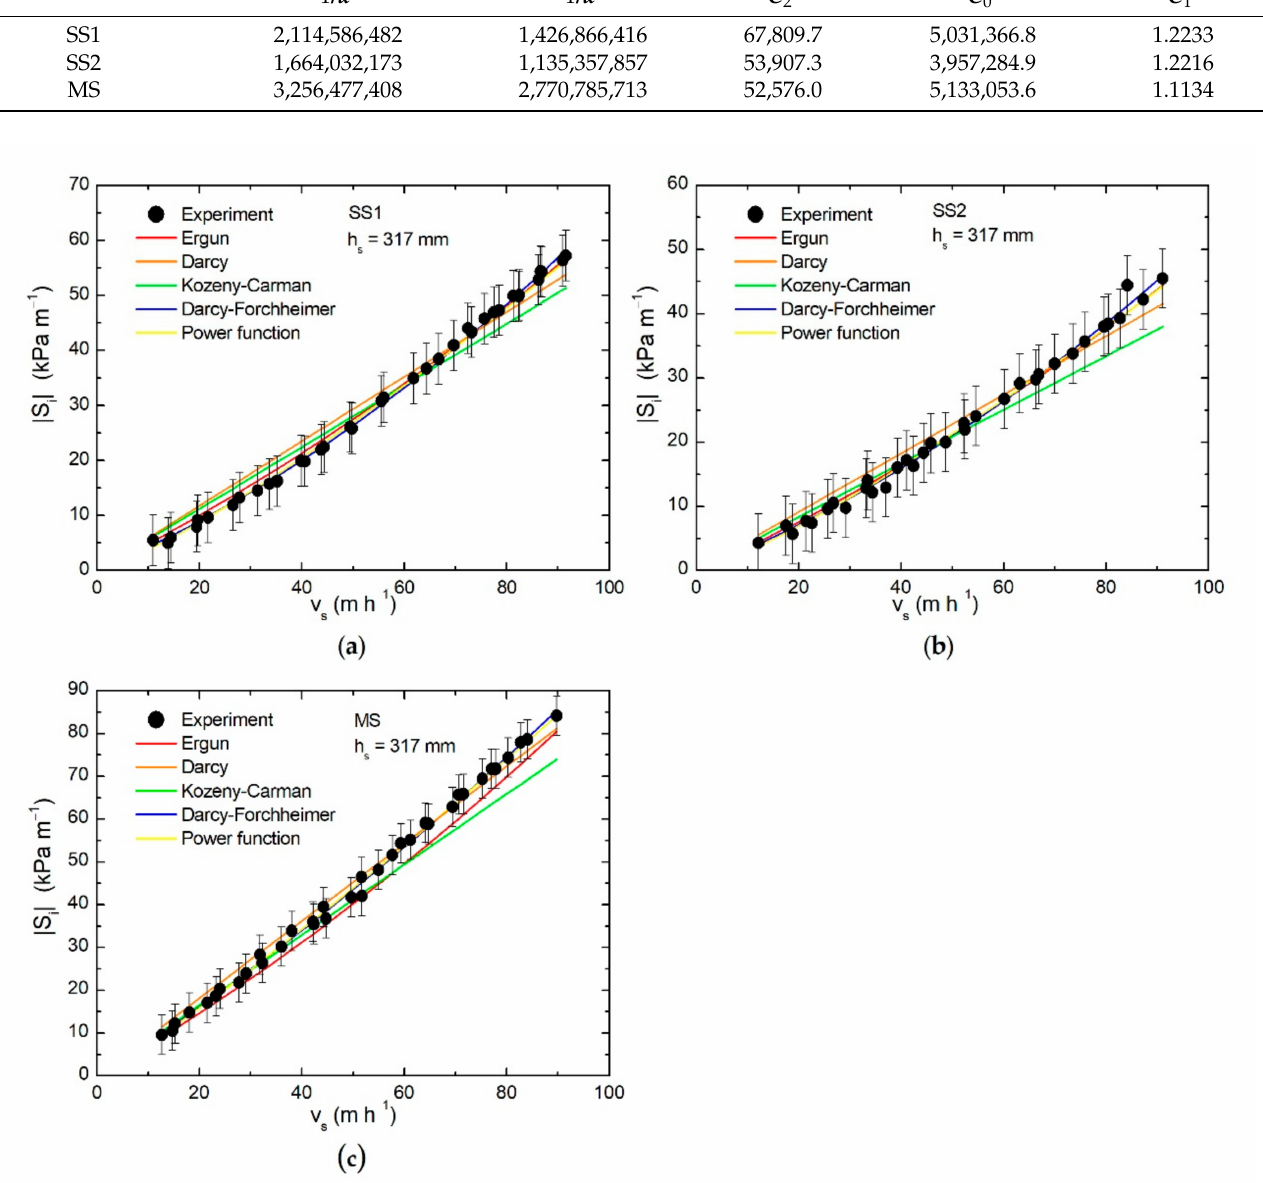
Figure 2. Regression fits of the absolute value of the observed momentum sink term in 200 mm of ( a ) silica sand 1, ( b ) silica sand 2, ( c ) microspheres as a function of the superficial velocity for Darcy Equation (7) (linear), Darcy-Forchheimer Equation (9) (quadratic) and power function Equation (11) (logarithmic). Trends from Kozeny-Carman Equation (8) and Ergun Equation (10) are also shown. Uniform flow in these 200 mm was